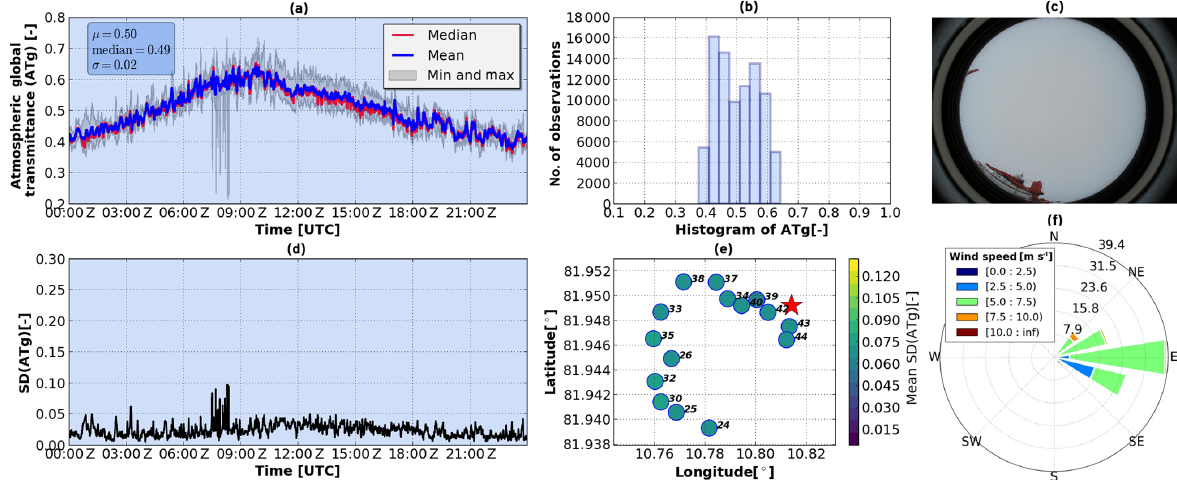
Figure 7. Overview of overcast case: the same as Fig. 6 but for 6 June 2017, 00:00–23:59Z. All-sky camera photograph taken at 13:41:54Z.